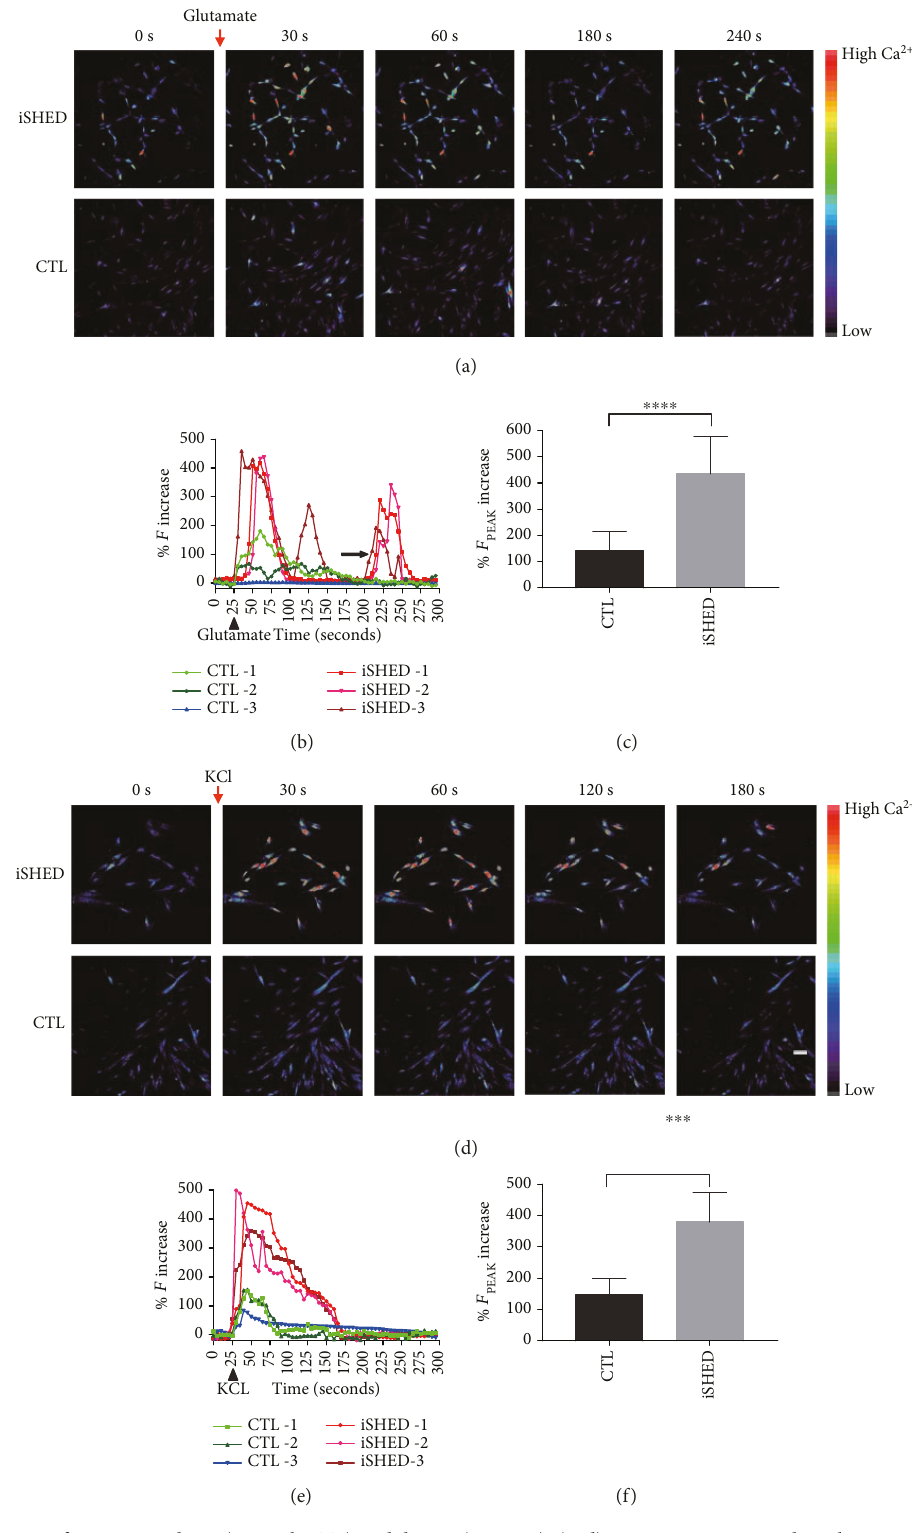
Figure 4: Ca 2+ activity of SHEDs on day 0 (control, CTL) and day 24 (iSHEDs). (a, d) Representative pseudo-color images showing a greater fl uorescence increase in induced cells than in controls after exposure to glutamate (a) and high K + (d) (color code denotes Ca 2+ level). (b, e). Representative Ca 2+ transient pro fi les with time displaying higher Ca 2+ in fl ux peaks in the induced cells than in the controls ((b) for glutamate, (e) for KCl); the arrow indicates second or third Ca 2+ in fl ux peaks in induced SHEDs (b). (c, f) Histograms showing the fl uorescence intensity at the peak time was higher in the induced cells than in controls ((c) for glutamate, (f) for KCl) ( ∗∗∗ p < 0 001 and ∗∗∗∗ p < 0 0001